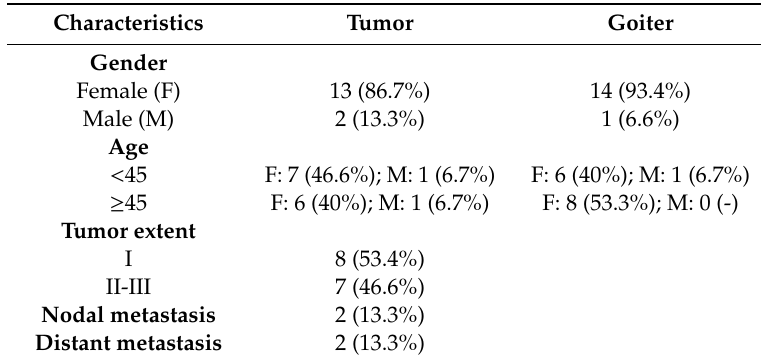
Table 1. Characteristics of the collected samples.